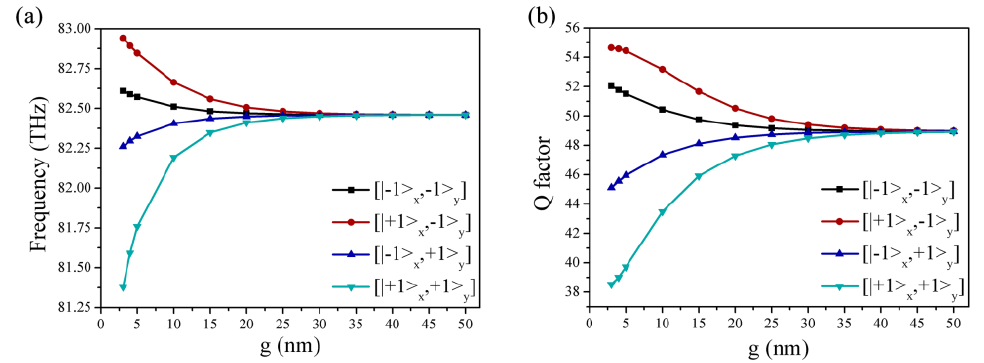
Figure 3. ( a ) Frequency and ( b ) Q factor of the collective modes TM 2,1 as a function of g of the four categories of symmetry, where μ c2 = μ c3 = 0.5 eV, μ c1 = 0.1 eV and R = 50 nm.